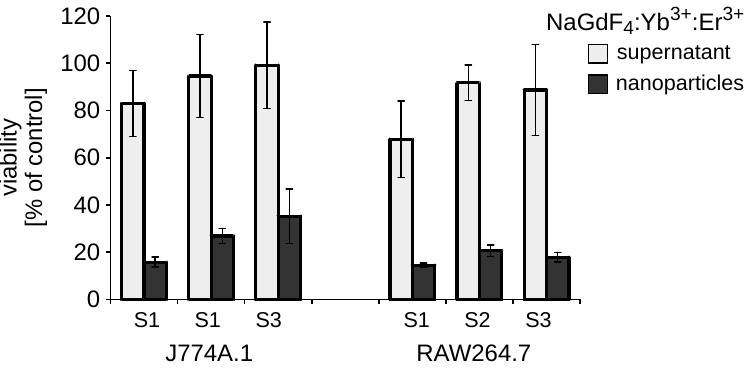
Figure 3. Comparison of supernatant ‐ induced and NP ‐ induced cytotoxicity. Viability of RAW264.7 and J774A.1 cells was assayed after a 48 ‐ h treatment with 5 μ g/mL NaGdF 4 ‐ based NPs. The means ± SD are shown ( n = 3).